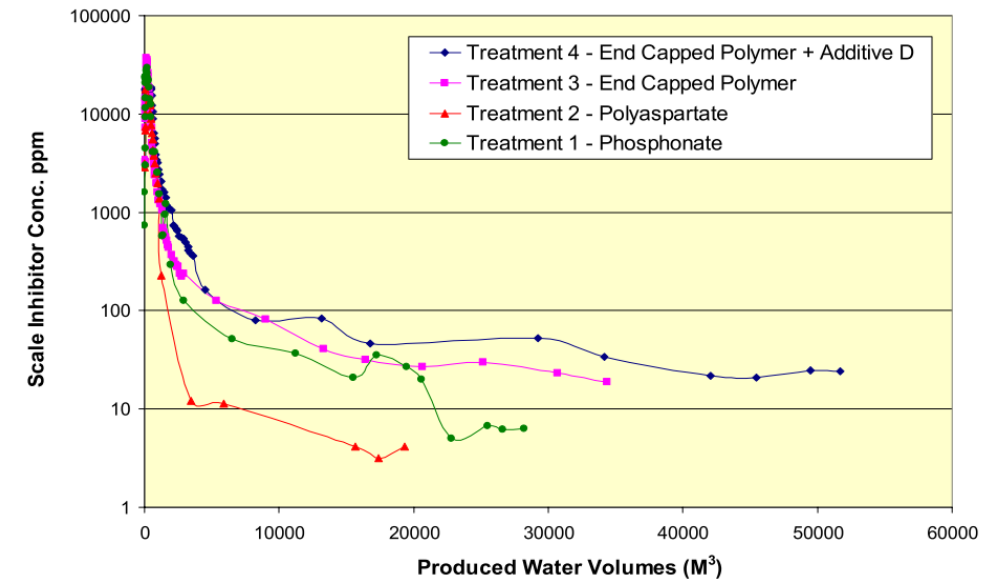
Figure 15. Comparison of inhibitor return profiles at different field treatments [ Error! Reference source not found. ].